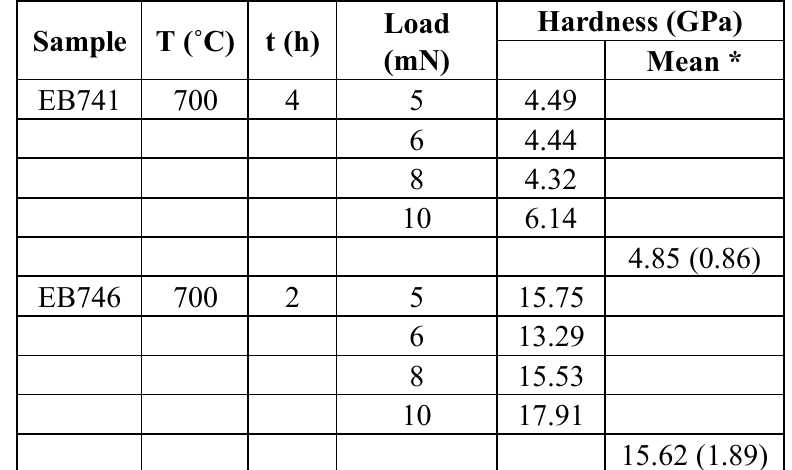
Table 3. Summary of nanoindentation hardness measurements for selected Ti annealed at 2